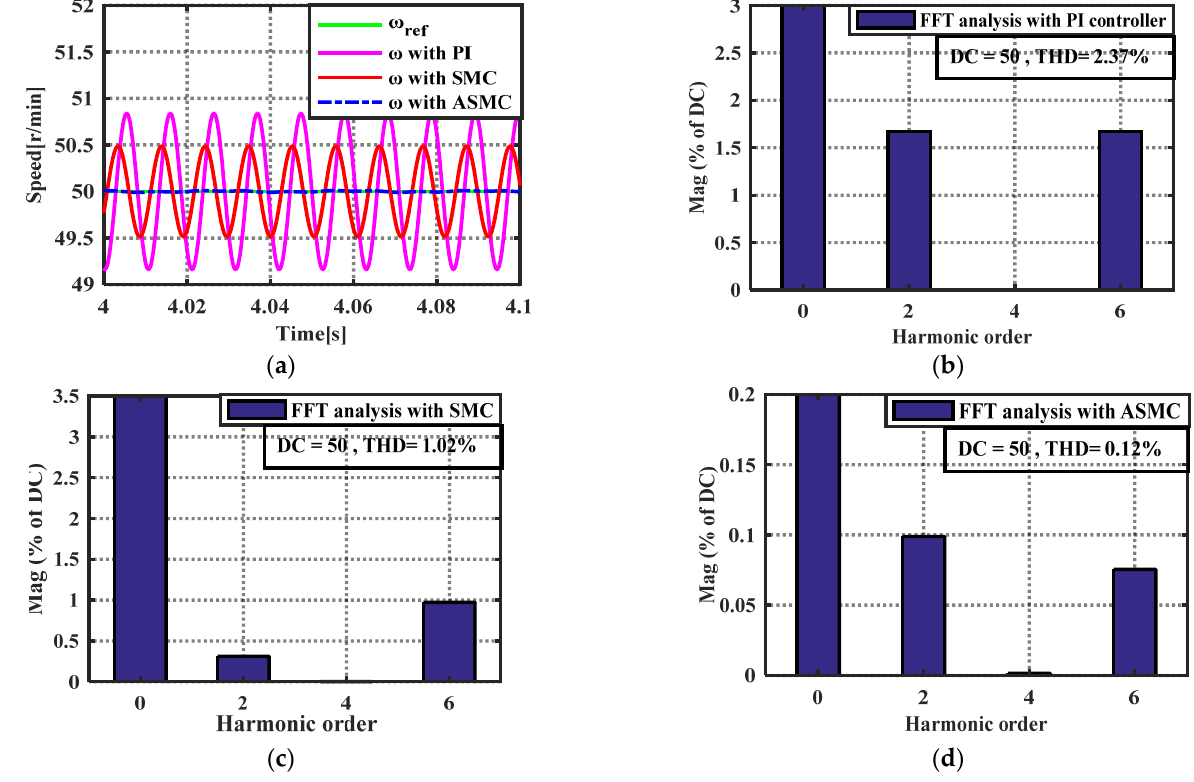
Figure 7. Steady state performance of the speeds and their FFT analysis. ( a ) Speed curves using three control methods; ( b ) FFT analysis of the speed using PI controller; ( c ) FFT analysis of the speed using SMC; ( d ) FFT analysis of the speed using ASMC.